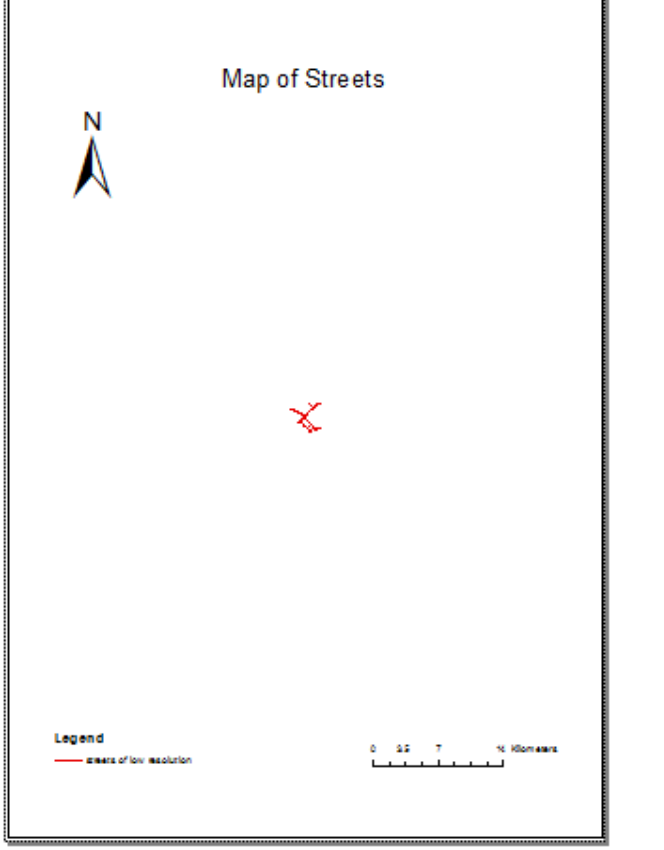
Fig.18: Presented the network road map for low resolution image with 1:250,000